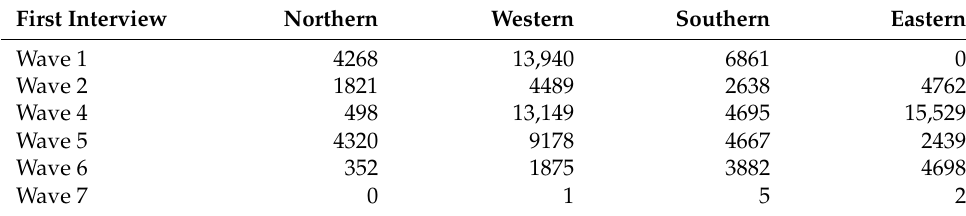
Figure 1. Study flow diagram. Table 1. Number of participants by region and Wave of first